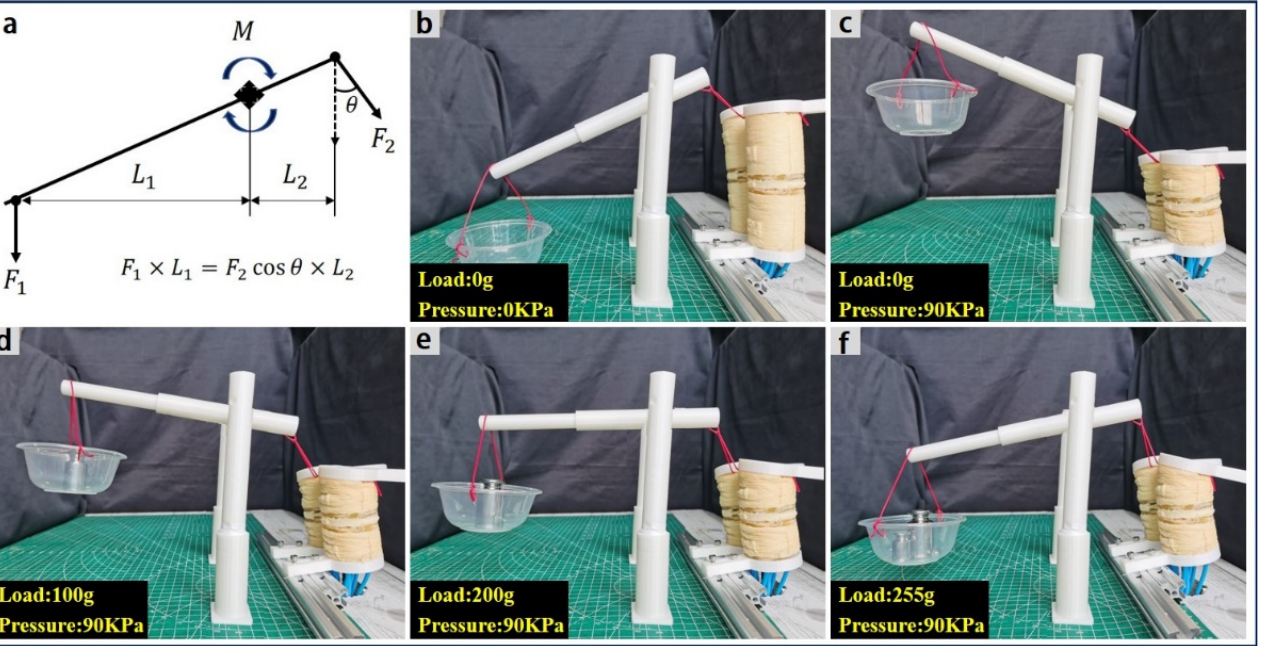
Figure 10. Soft robot used as a lifting device: ( a ) mechanism force analysis diagram. ( b , c ) Lifting without a load; ( d – f ) lifting 50, 100, and 255 g loads at an air pressure of 90 kPa.